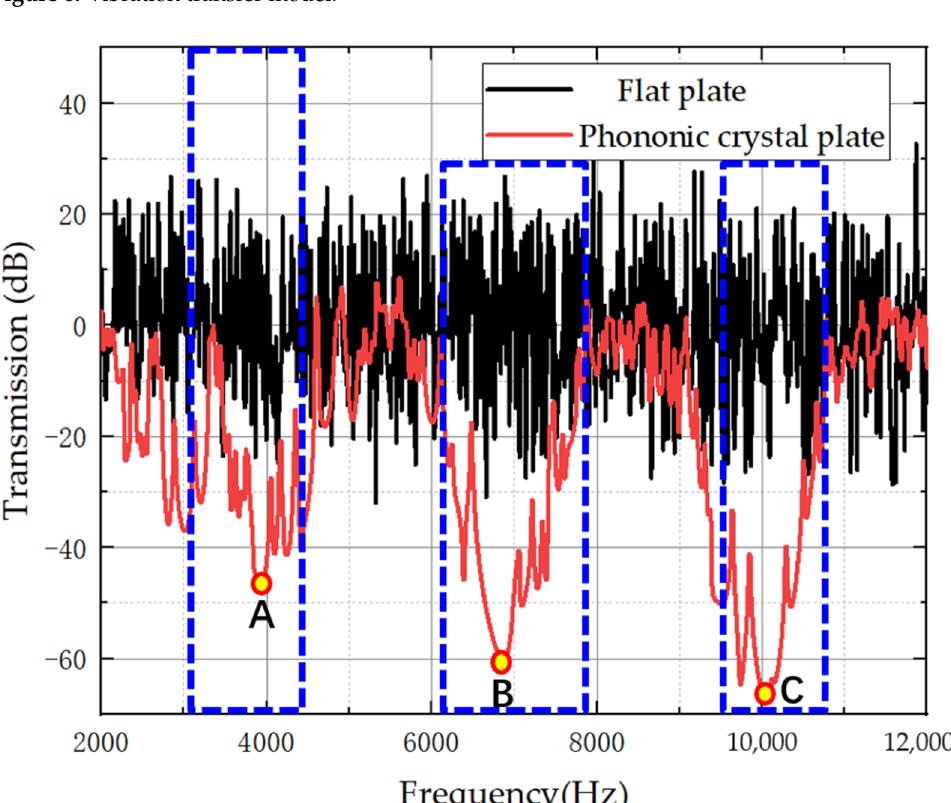
Figure 7. Transmission from point P2 to point P1 .